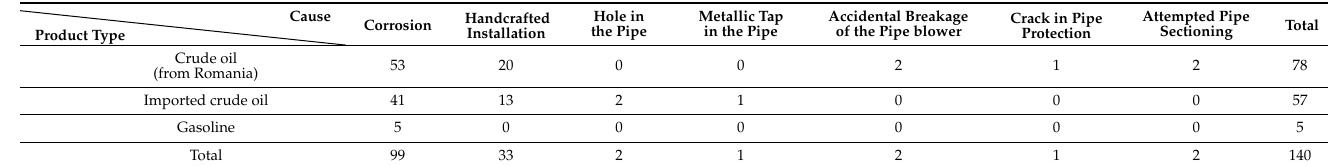
Table 16. The cross-tab for product type and cause.